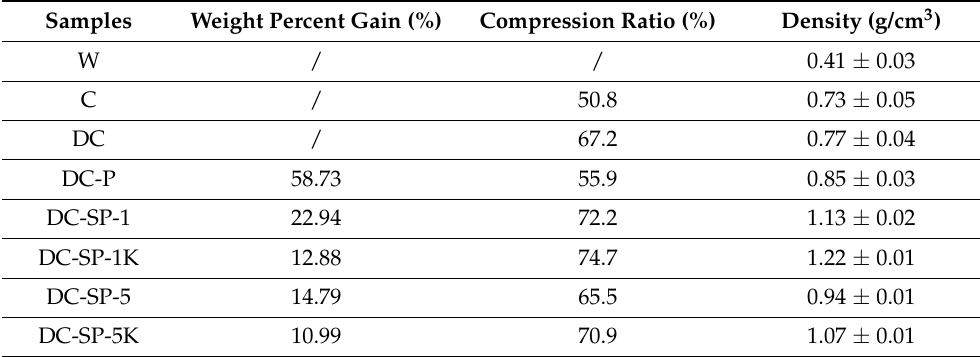
Table 2. WPG, CR, and density